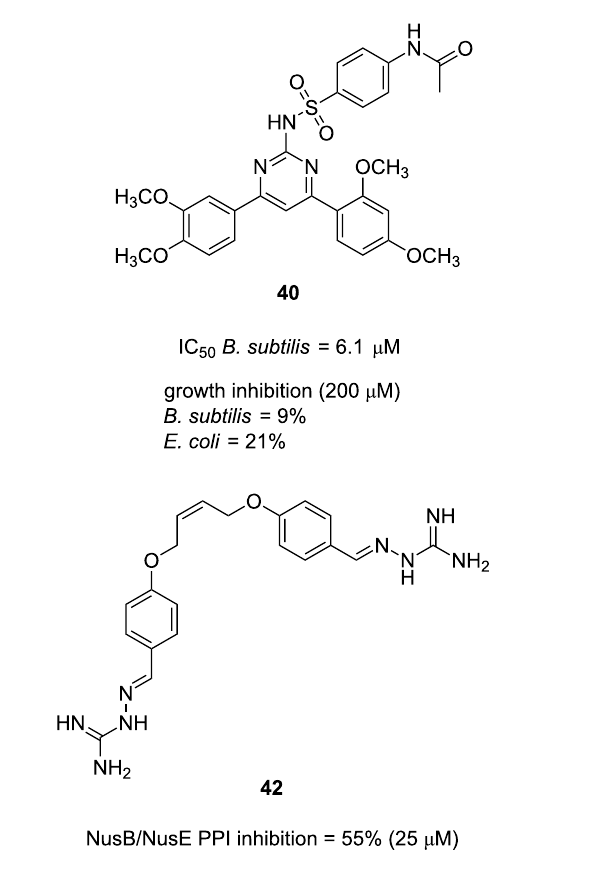
ate inhibitor of the growth of the Gram-positive pathogen B. subtilis and the Gram-negative microorganism E. coli